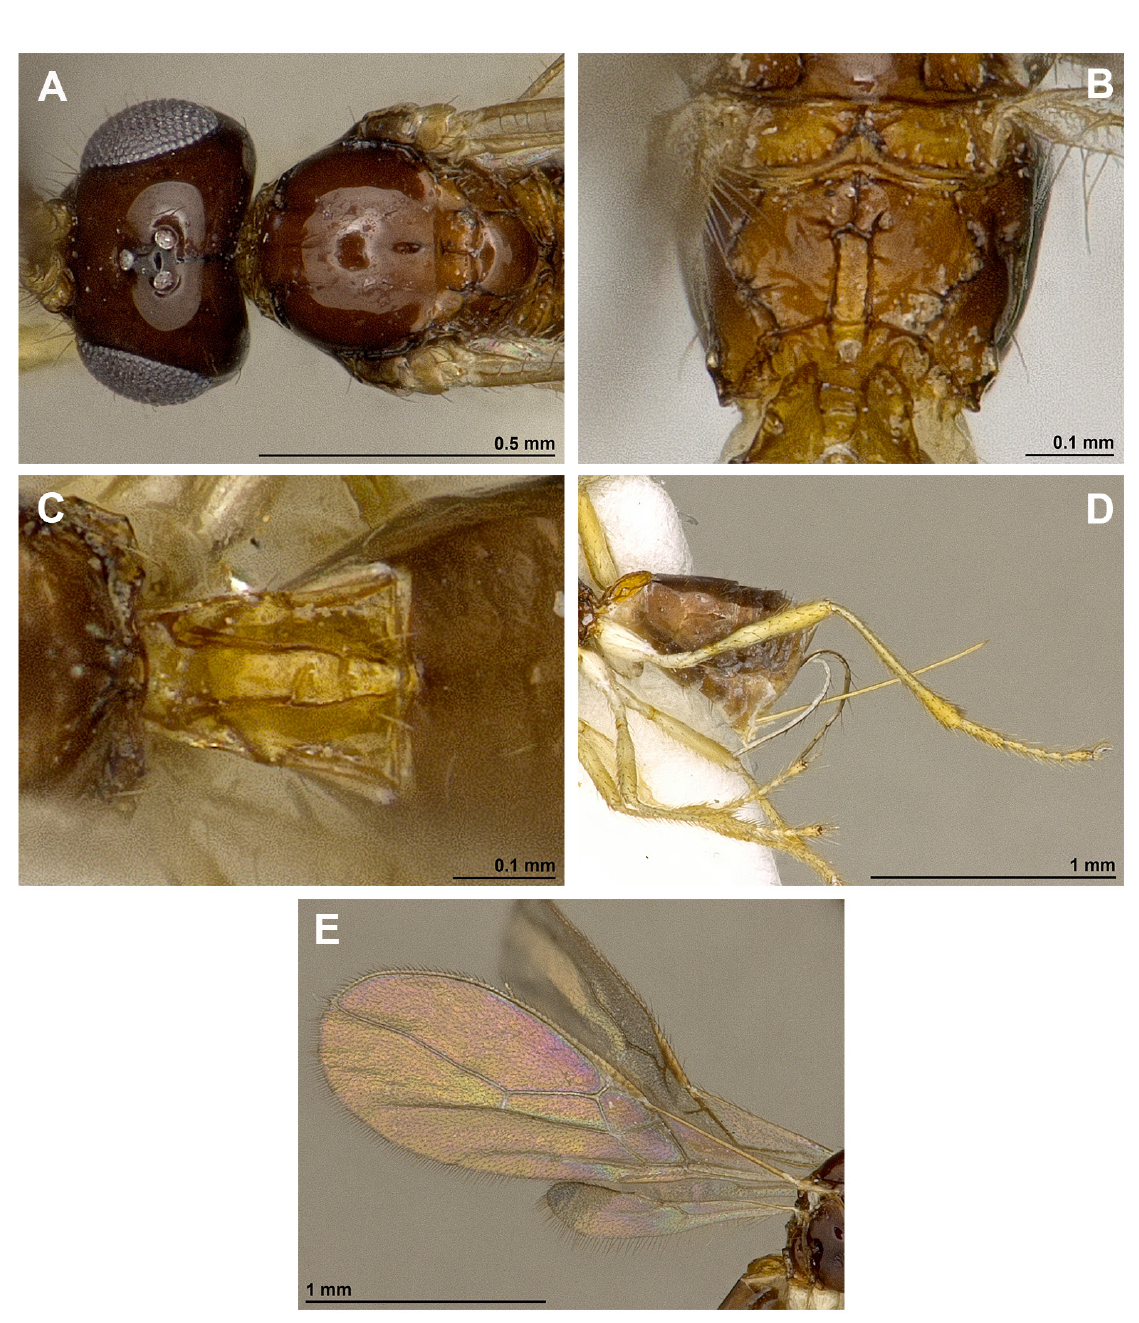
Fig. 32. Asobara kibalensis van Achterberg, sp. nov., ♀, holotype (RMNH). A . Head and mesoscutum, dorsal view. B . Propodeum, dorsal view. C . First metasomal tergite, dorsal view. D . Hind leg, metasoma and ovipositor, lateral view. E . Fore and hind